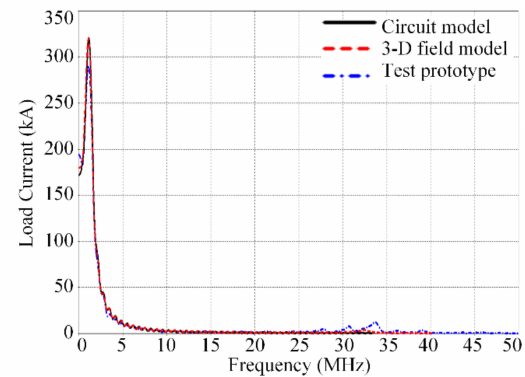
Figure 19. Load current waveforms of the single-stage FLTD in the frequency domain.